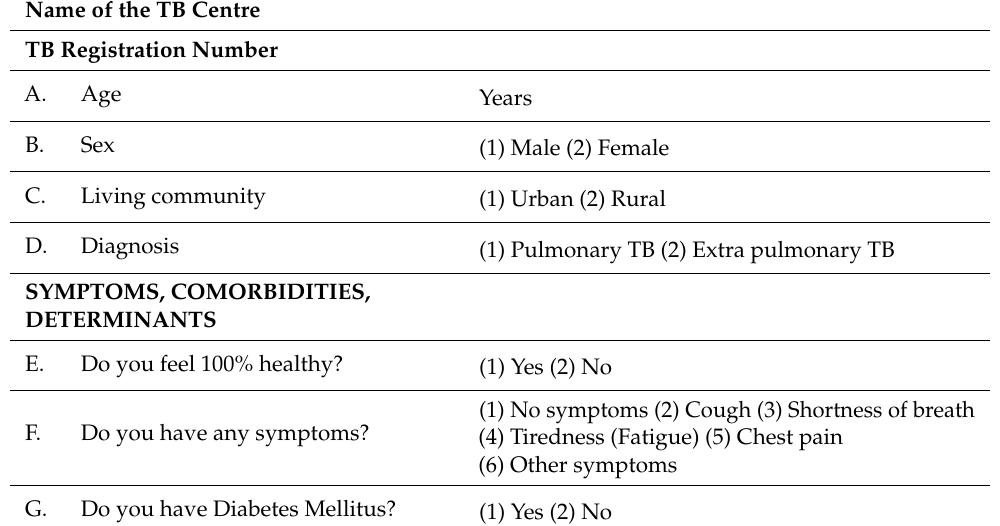
Table 2. End of Treatment TB Assessment